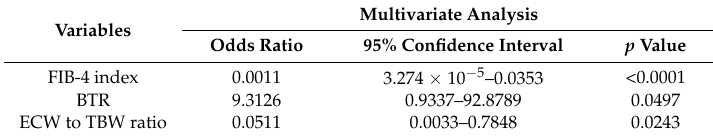
Table 5. Significant factors in the multivariate analyses for the presence of CONUT ≥ 2. Variables